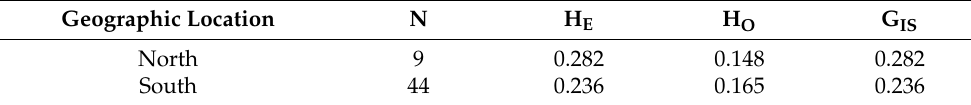
Table 1. Summary statistics of Callinectes ornatus genetic groups from the north and south sides of the Amazon–Orinoco Plume (AOP). Values are based on the analysis of 899 SNPs from across the genome. Geographic location: indicates the number of individuals collected on the north or south side of the plume and included in the analyses after all filtering steps. N: number of individuals after all filtering steps. H E : expected heterozygosity. H O : observed heterozygosity. G IS : inbreeding coefficient. Geographic Location N H E H O G IS North 9 0.282 0.148 0.282 South 44 0.236 0.165